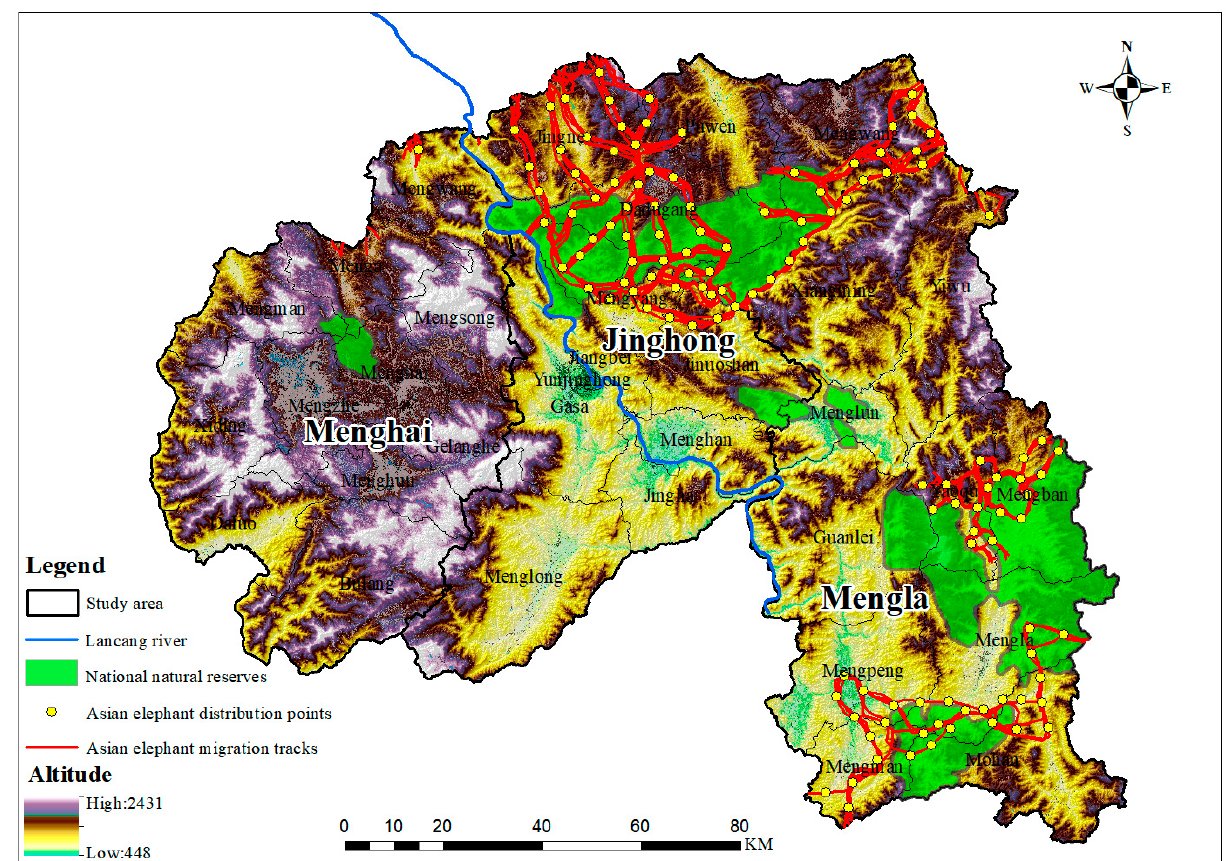
Figure 2. The study area (the map contains elevation data and Asian elephant migration tracks) in Sipsongpanna Prefecture (Menghai County, Mengla County, and Jinghong City). Sipsongpanna Prefecture (Menghai County, Mengla County, and Jinghong